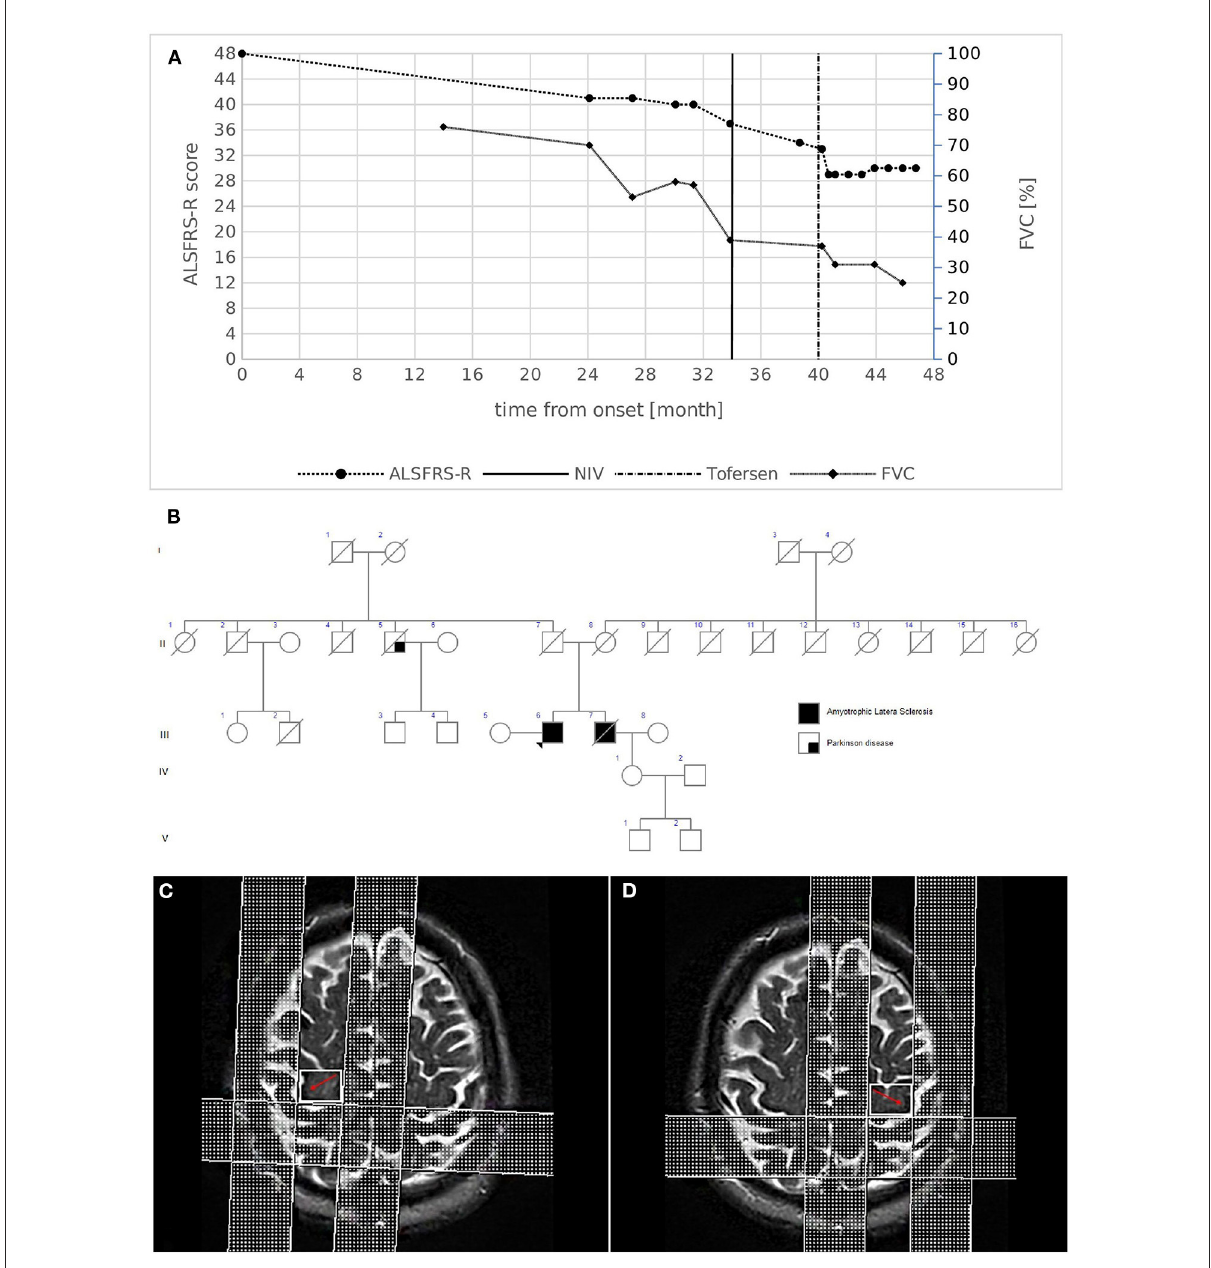
FIGURE1 (A) Disease course of case 1. The graph shows ALSFRS-R total score (left) and FVC % (right) decline from disease onset. The bold vertical line represents the time when NIV was initiated, while the dashed vertical line represents the beginning of intrathecal Tofersen administration. (B) Family pedigree of case 1. Filled circle/square, affected individuals; open circle/square, unaffected individuals; arrow, proband; diagonal line, deceased individuals. The proband’s mother died at 79 years of age from HCV infection complications and chronic COPD; the father died at 94 years of age after a hip fracture. A paternal uncle died at an advanced age because of Parkinson’s disease. (C,D) Brain MRI images of case 1. MRI T2-weighted images revealing the hypointensity along the bilateral motor cortex (red arrows).